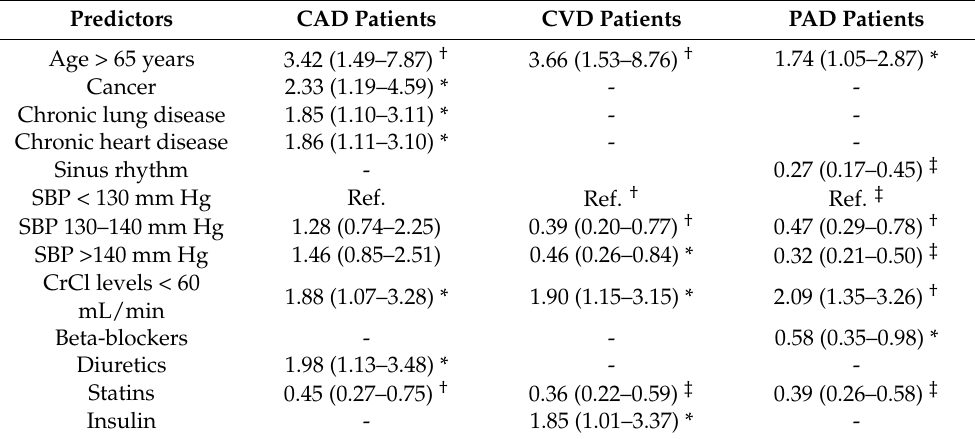
Table 4. Predictors for mortality. Multivariate